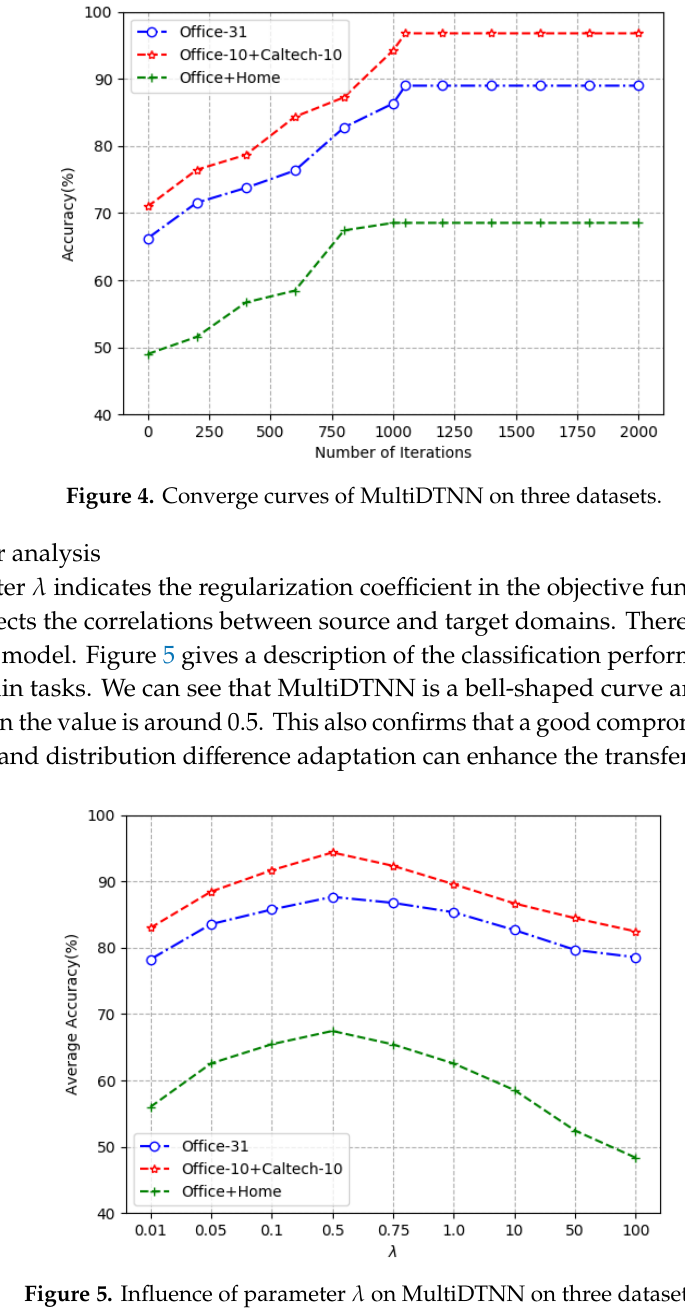
Figure 5. Influence of parameter λ on MultiDTNN on three datasets.